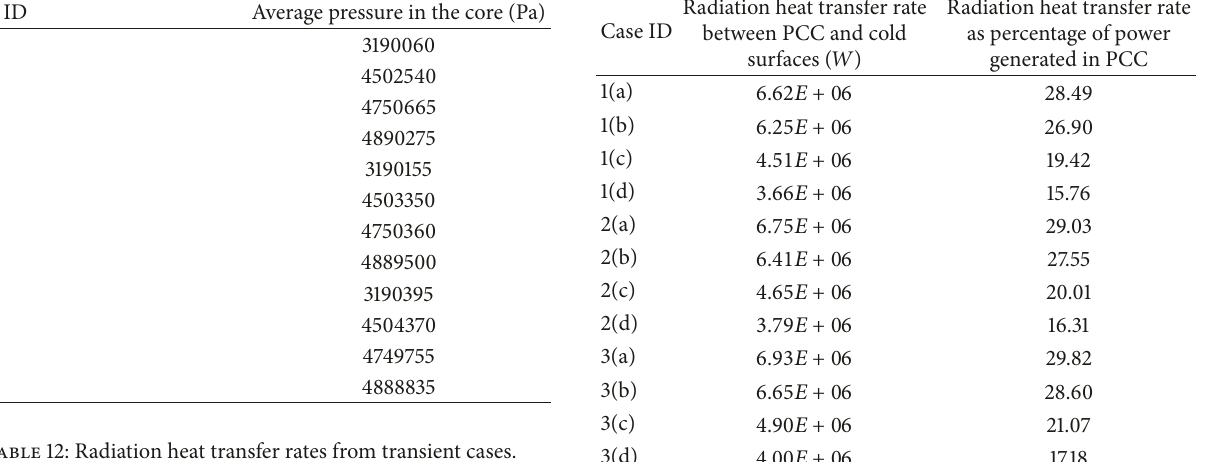
Table 12: Radiation heat transfer rates from transient cases. Radiation heat transfer rate Case ID between fuel elements and